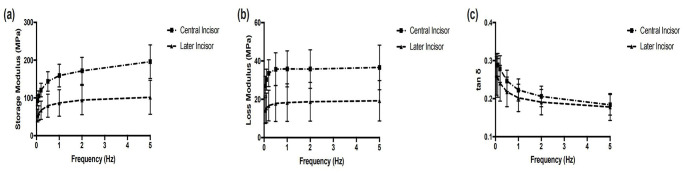
Fitting curves of storage modulus (a) and tanδ(b) for all human PDL specimens.Data points represent the respective mean values for the specimens.